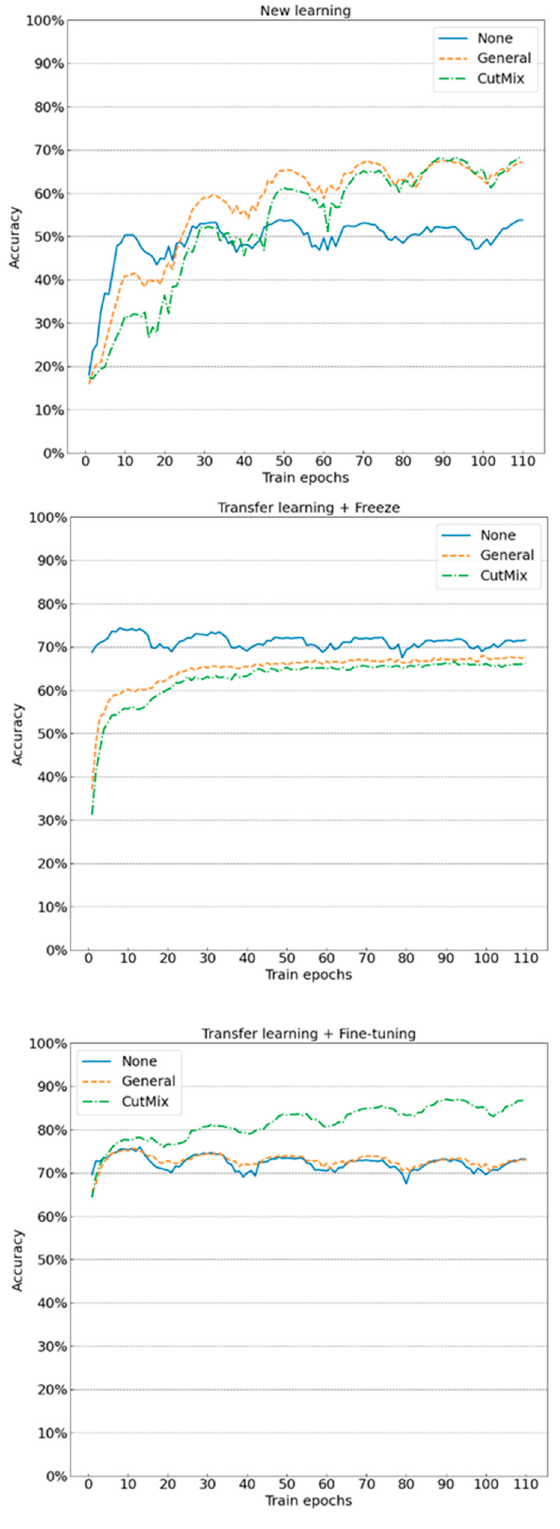
Figure 7. Accuracy of models with different data augmentation methods.